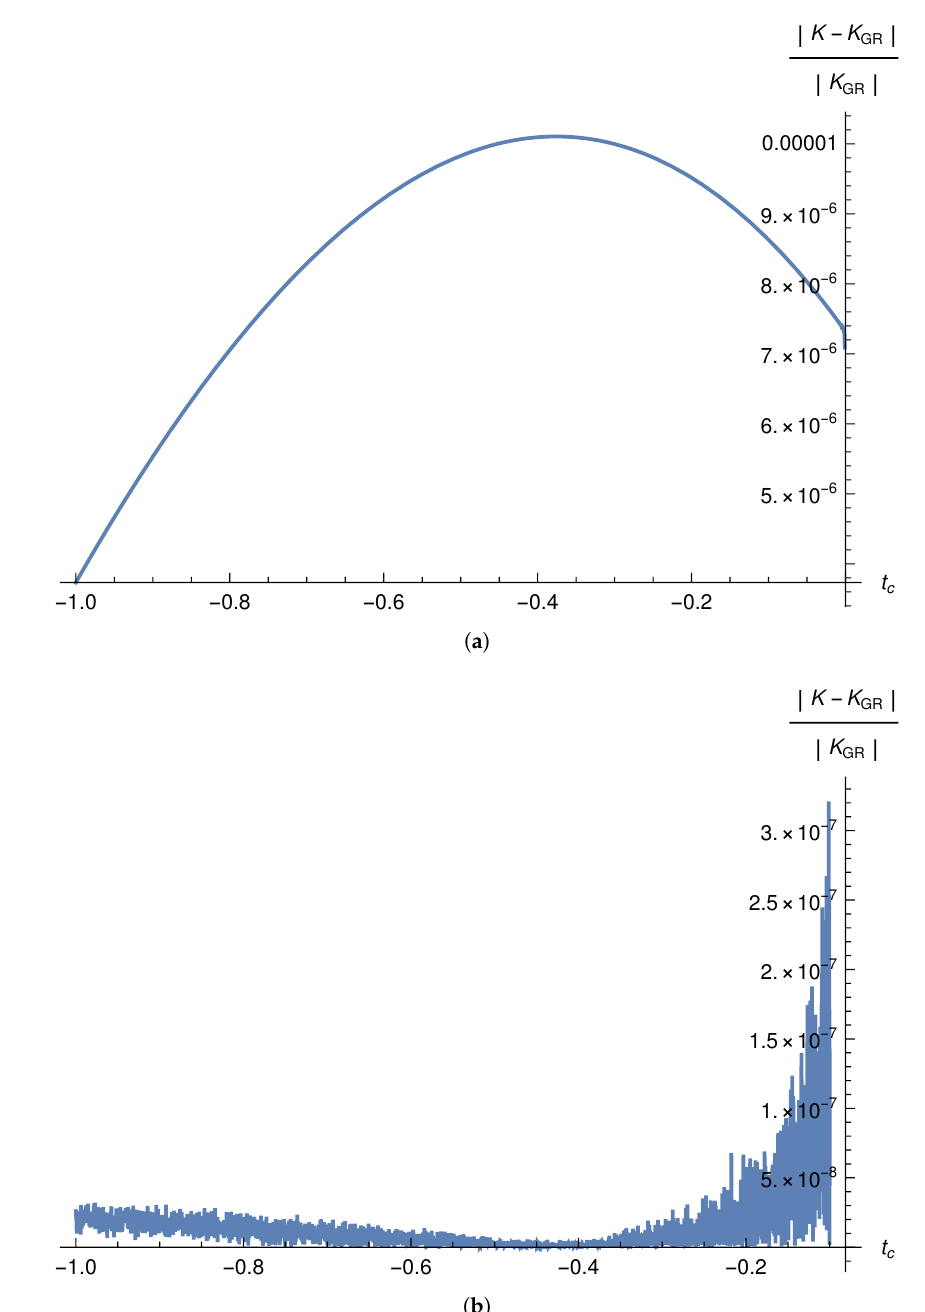
Figure 4. Plots of the relative difference between the Kretschmann scalars K and K GR in the α 1 = 0 case, for ( a ) m = 10 6 , and ( b ) m = 10 12 . Here K GR ( ≡ 48 m 2 /p 3 scalar given by